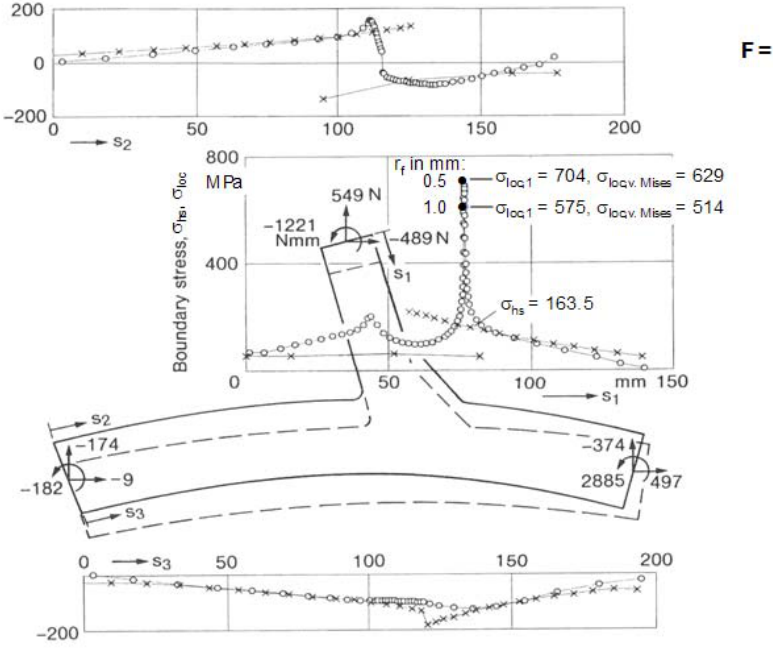
Figure 13: Hot-spot and weld local notch stresses in the critical area of the weld